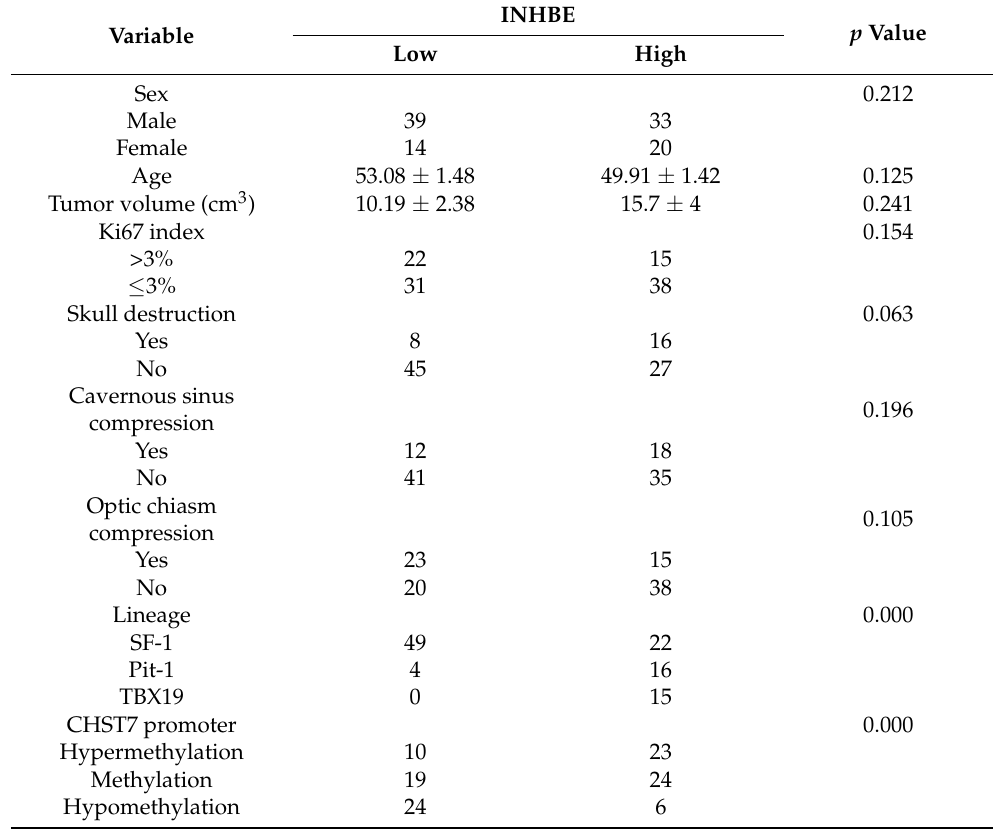
Table 4. Association between INHBE expression and clinicopathological